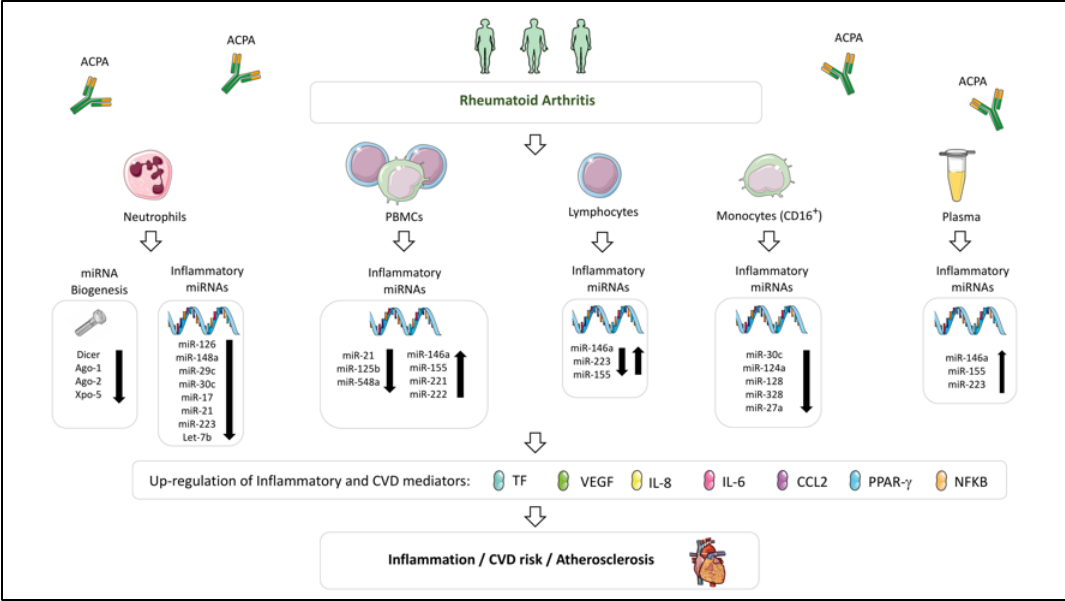
Figure 3. Dysregulated miRNA profile involved in the development of CVD in Rheumatoid Arthritis. Altered levels of miRNAs have widely been described in immune cells (neutrophils, PBMCs, lymphocytes and monocytes) and plasma of rheumatoid arthritis patients. This dysregulation would modulate the expression of inflammatory and CVD mediators, favoring the development of atherosclerosis and CVD. In these miRNA alterations, a relevant role has been attributed to the presence of anti-citrullinated protein antibodies (ACPAs).